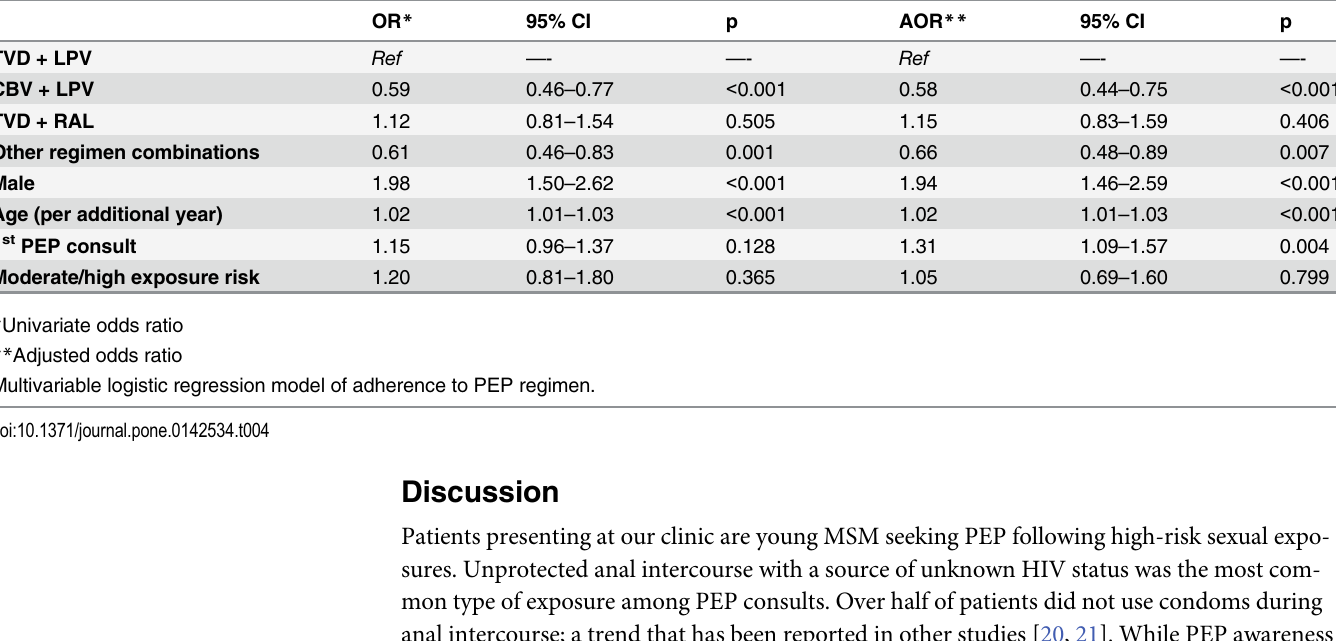
Table 4. Factors associated with adherence to PEP regimen (N = 2731).